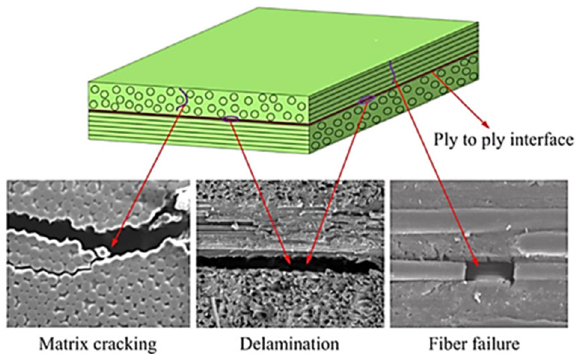
Figure 12. Fibre failure and matrix failure within mode I fatigue loading.